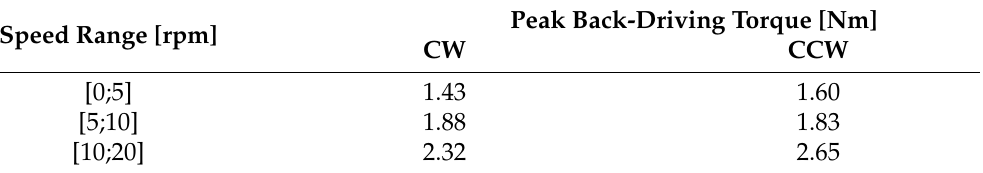
Table 2. Peak values of the back-driving torque observed by moving the output arm by hand while measuring the strain gauges for three different speed